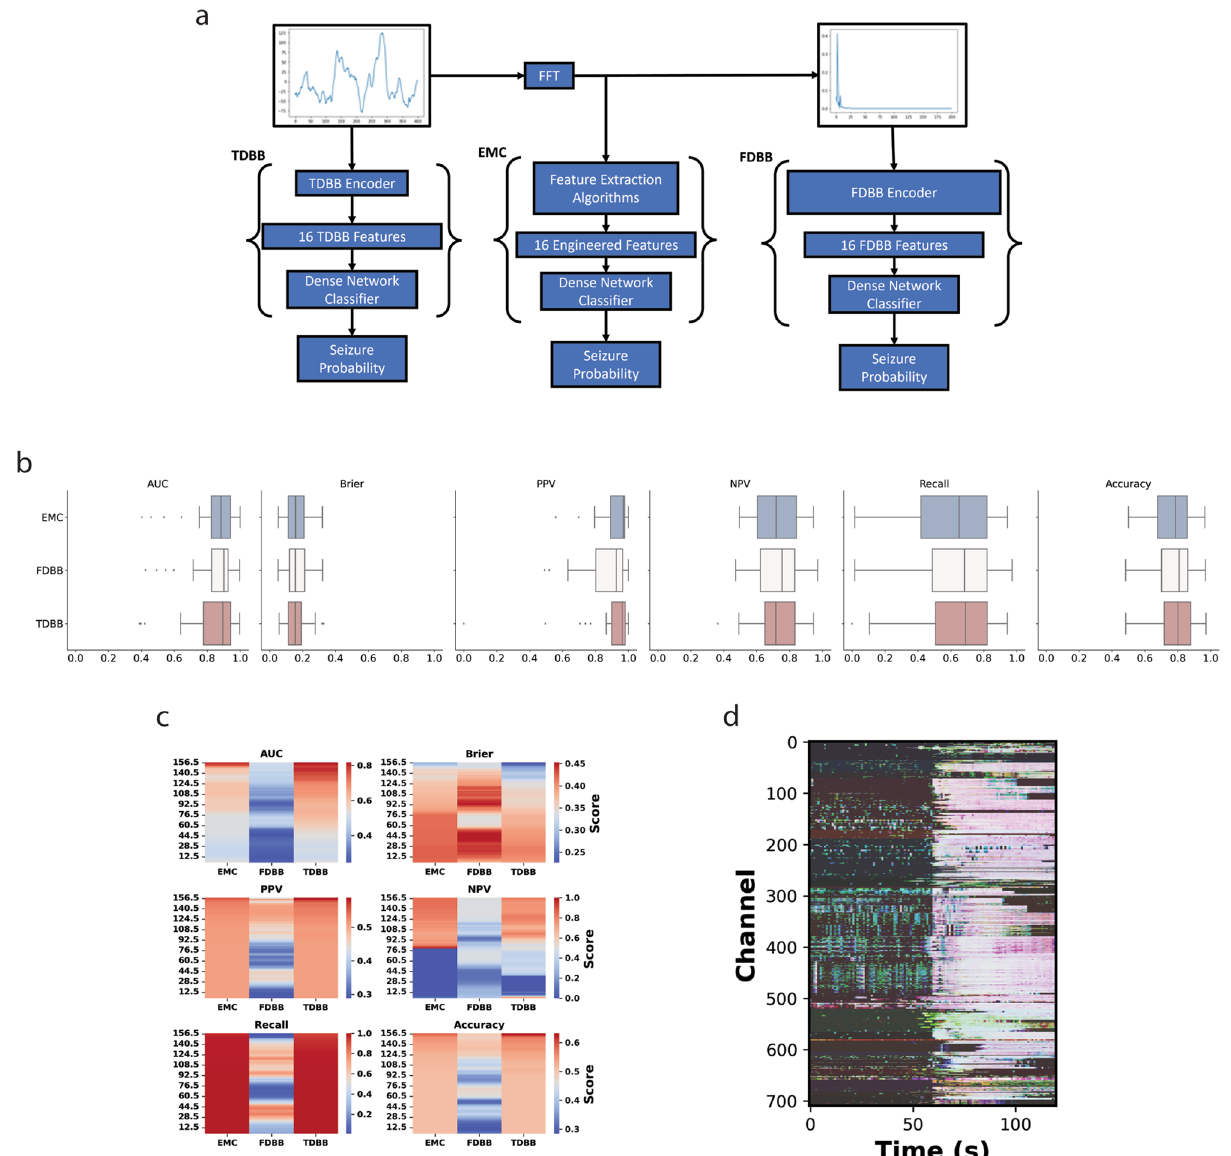
Figure 1. Neural network architectures, leave one out (LOO) pretraining, and evaluation. ( a ) Network schematic for each neural network. ( b ) LOO test set performance of each neural network on clinical (broadband) iEEG signals. ( c ) LOO test set performance on narrowband iEEG signals. ( d ) Visualization of model LOO test set predictions on iEEG